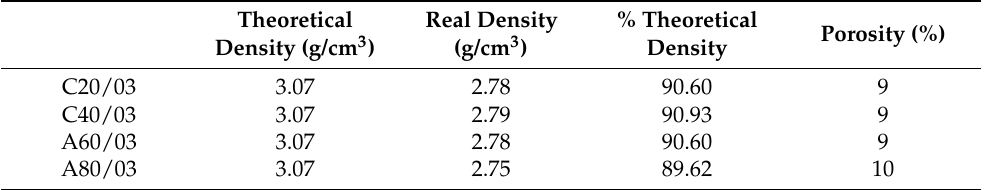
Table 6. Theoretical and real densities (g/cm 3 ) of the composite pad elements prepared with ELT rubber particles of different size (densities are given with ± 0.05